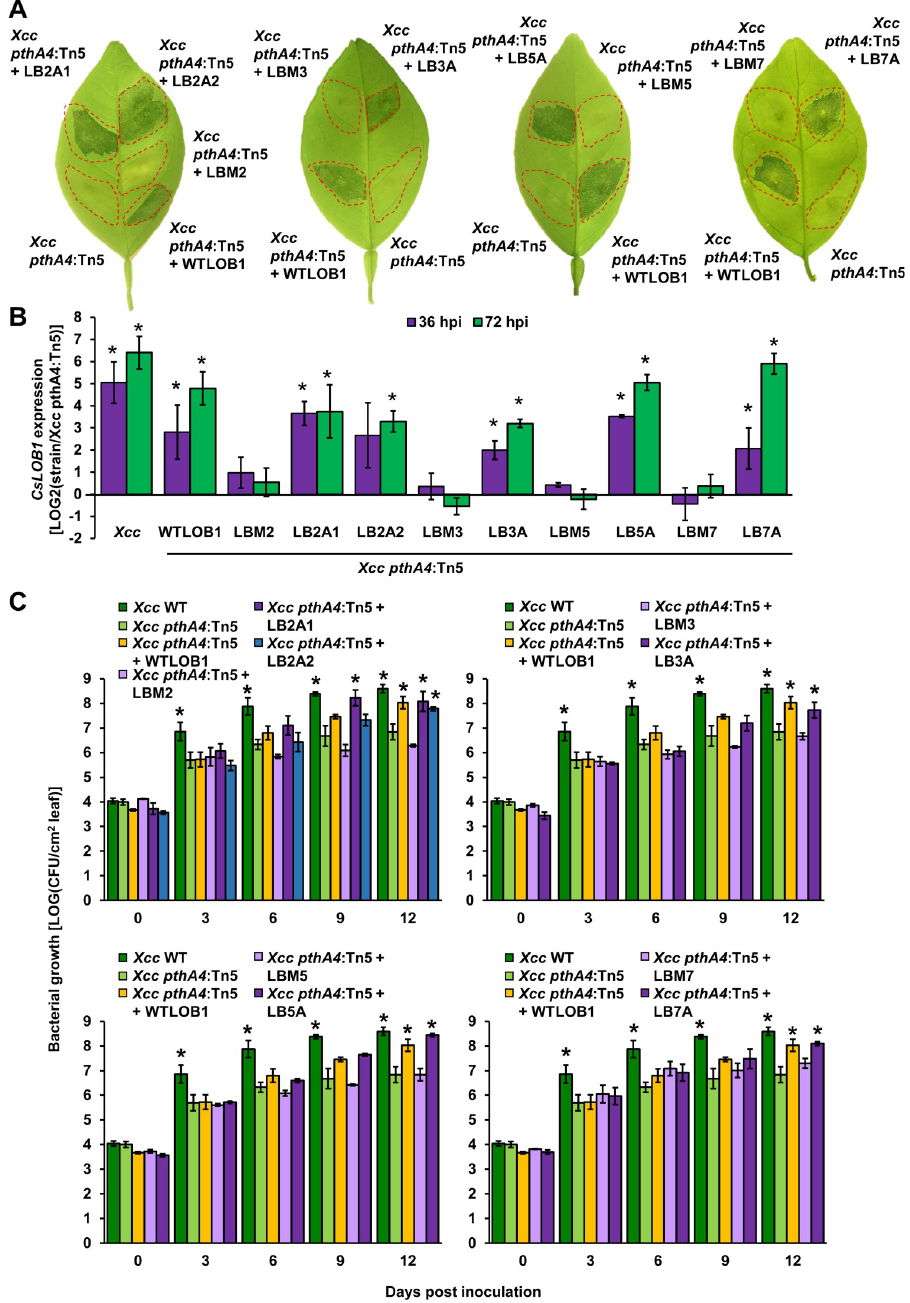
Fig 3. Functional characterization of adapted dTALEs. Sweet orange leaves were syringe-infiltrated with suspensions (1 × 10 8 CFU/mL for A and B, 1 × 10 6 CFU/mL for C) of Xcc 306 ( Xcc WT), Xcc pthA4 :Tn5 or Xcc pthA4 : Tn5 transformed with the parental and adapted dTALEs depicted in Fig 4A. A. Inoculated leaves were photographed at 7 days post inoculation. The experiments were repeated three times with similar results. B. The gene expression of CsLOB1 was quantified at 36 and 72 h post inoculation (hpi) using quantitative reverse transcription PCR. The GAPDH gene was used as an endogenous control. Values are means ± SE of three biological replicates. C. Bacterial growth in planta . Values represent means ± SE of three biological replicates. The experiments were repeated three times with similar results. B and C. Asterisks indicate a significant difference (Student’s t -test, P -value < 0.05) compared to Xcc pthA4 :Tn5.